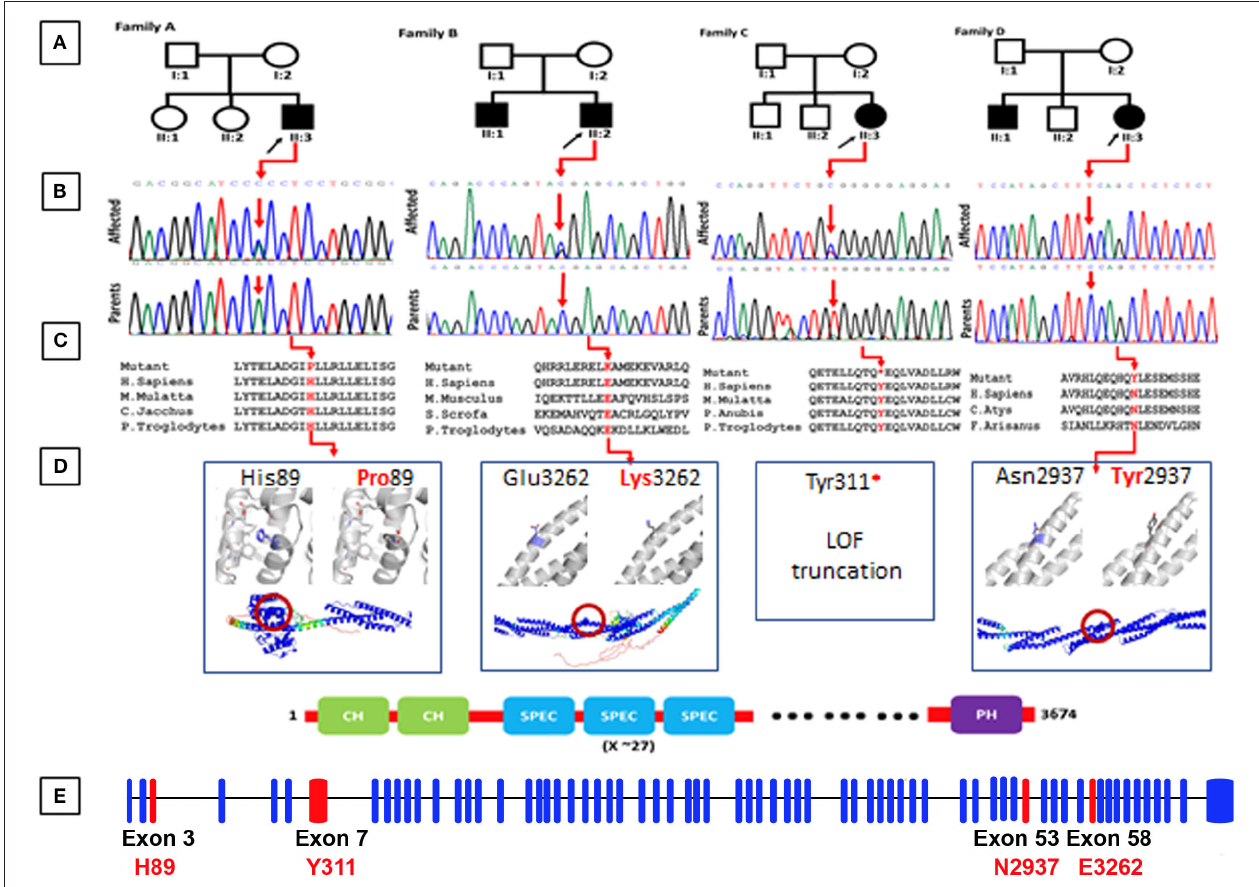
FIGURE 1 | (A) Representing pedigrees of all the four families (A–D). (B) Showing Sanger sequencing electro-grams of all the four families. (C) Conservation analysis of the mutations identified in the present studies along different species. (D) Structural models of the CH1 domain containing the His89Pro mutation, and the spectrin repeats containing the Asn2937Tyr and Glu3262Lys mutations. Three 1,000 segments containing the residues of interest were modeled with AlphaFold, and are shown in the bottom as cartoons, colored by pLDDT score. Residues with pLDDT < 50 are colored red, representing regions with low confidence, and residues with pLDDT > 90 are blue, showing high-confidence segments. The top insets show a zoom into the local region of each mutated residue (shown as blue sticks), and the comparison between the wild-type and mutated states. The residues predicted to interact with His89 are shown as gray sticks. (E) Exon organization of SPTBN5. Boxes are exons. Lines connecting the boxes are introns. Filled boxes are coding sequence, and empty, unfilled boxes are UTR (UnTranslated Region). Adapted from Ensembl (release 105) (Howe et al.,